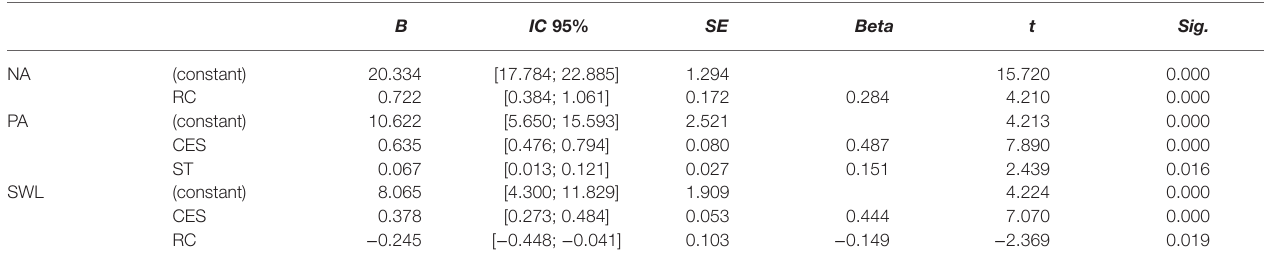
TABLE 4 | Regression analysis for Negative Affect, Positive Affect, and Satisfaction with Life. B IC 95% SE